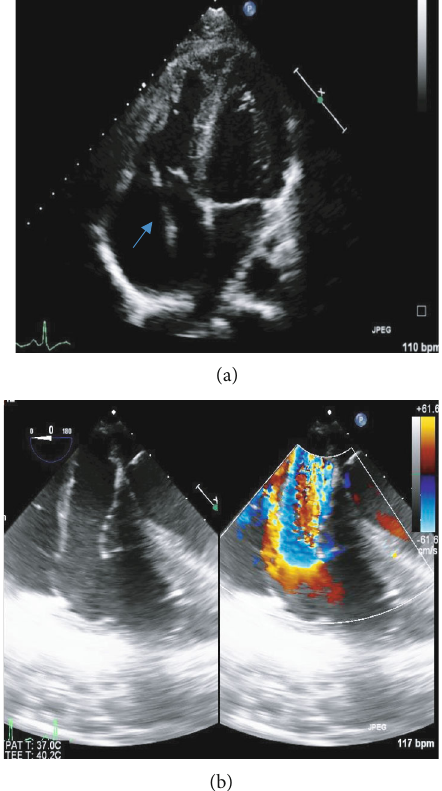
Figure 2: (a) Transthoracic apical 4-chamber echocardiographic view showing fl ail anterior tricuspid valve lea fl et (arrow) and (b) transoesophageal right ventricle long axis views depicting severe tricuspid valve regurgitation.